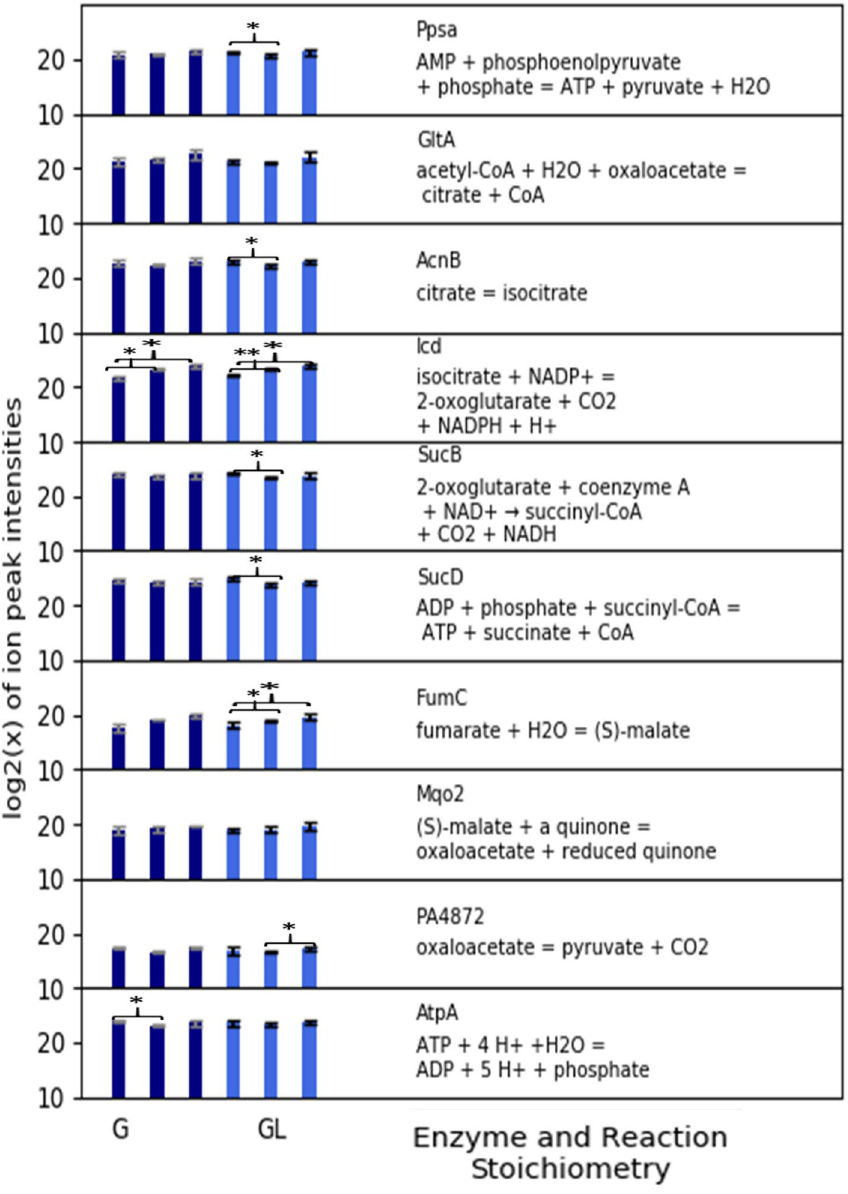
Figure 3. Proteomics data for P. aeruginosa 215 grown on chemically-defined, CSP G and CSP GL medium which contained glucose (G) or glucose and lactate (GL), respectively. CSP G culture data are represented by dark blue bars and CSP GL culture data are represented by light blue bars. Bars quantify the abundance of the enzyme during the first exponential growth phase (4 h), early second exponential growth phase (7 h), and late second exponential growth phase (11 h). Presented enzymes are involved in the tricarboxylic acid (TCA) cycle, anaplerotic reactions, and ATP synthesis. All values are averaged from three biological replicates. * p value < 0.05; ** p value <